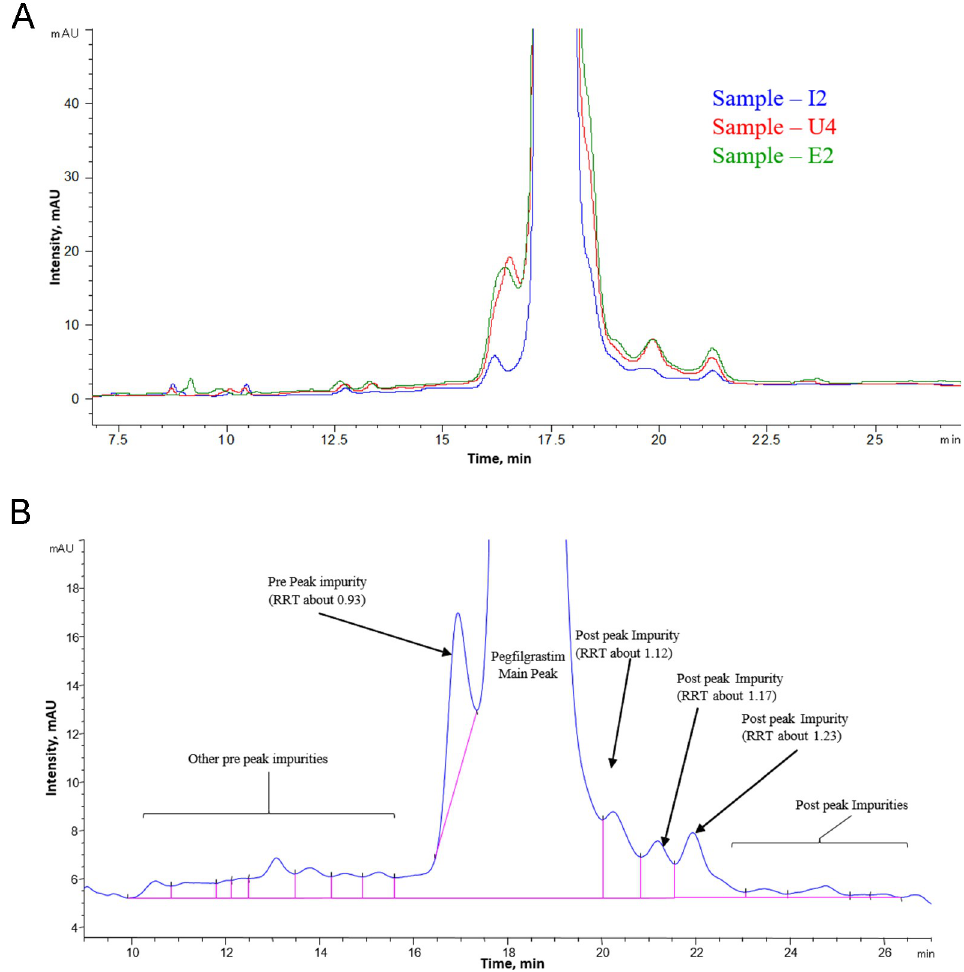
Fig 11. (A) Overlay of RP chromatographic profile of INTP5, US Neulasta and EU Neulasta (Sample I2, U4 and E2) (B) Representative RP-HPLC profile of INTP5 zoomed at the baseline to reveal the maximum possible